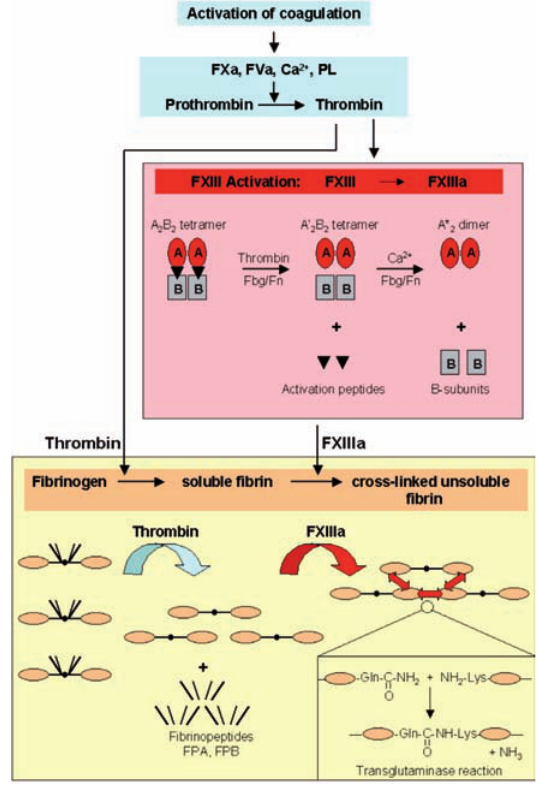
Figure 1 Activation and cross-linking reaction of FXIII After activation of coagulation, thrombin is formed by the prothrombinase complex consisting of activated factors X and V (FXa, FVa), calcium ions (Ca 2+ ) and phosholipids (PL) (blue boxes). Thrombin converts fibrinogen into soluble fib- rin by cleaving fibrinopeptides A and B (FPA, FPB) (yellow box) and initiates FXIII activation by cleaving FXIII activation peptide (red box). FXIII activation is completed by dissocia- tion of the A- and B-subunit induced by Ca 2+ . Both FXIII acti- vation steps are enhanced by fibrinogen and fibrin (Fbg/Fn). Activated FXIII (FXIIIa) cross-links Lysine (Lys) and Gluta- mine (Gln) residues of soluble fibrin molecules in a trans- glutaminase reaction (yellow